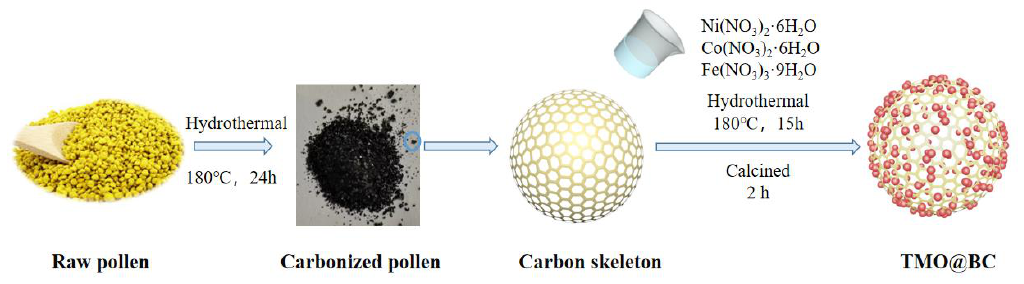
Figure 1. Schematic diagram of the hydrothermal method for Fe 2 O 3